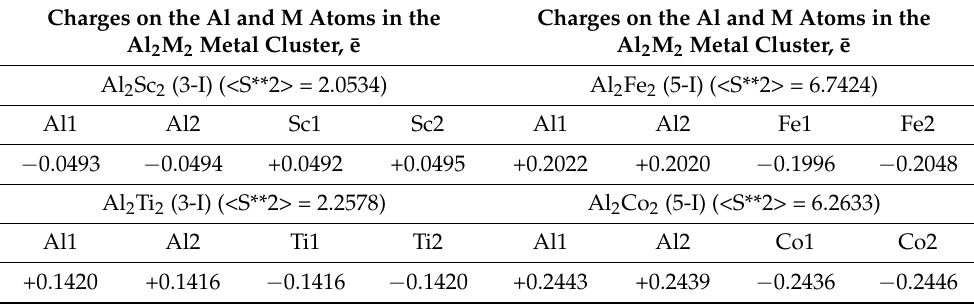
Table 5. Charge distribution (in units of electron charge) on various Al and M atoms and the values of operator of the square of the proper angular momentum of the total spin of the system <S**2> for most stable Al 2 M 2 metal clusters according to NBO analysis data (M − 3 d -element). Charges on the Al and M Atoms in